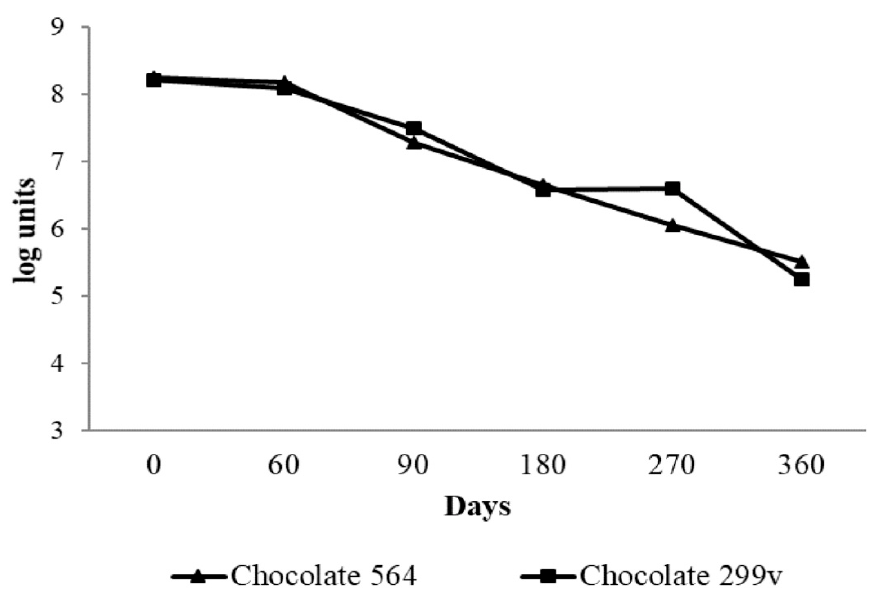
Figure 1. Viability of spray dried Lb. planatrum 564 and commercial probiotic Lb. plantarum 299v in dark chocolate during storage.